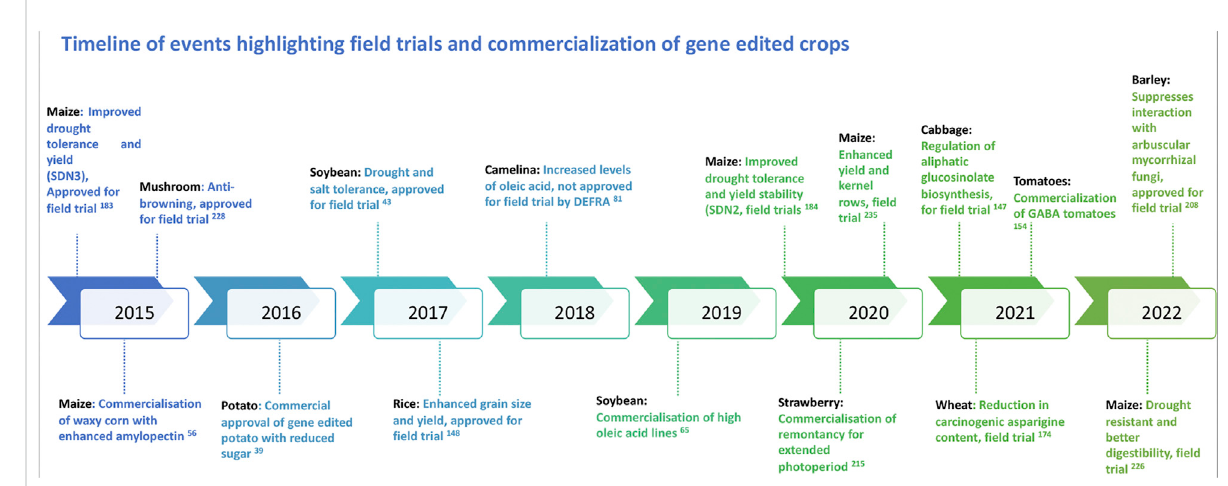
FIGURE 2 Diagrammatic representation of the timeline of events highlighting the fi eld trials and commercialization of gene edited crops